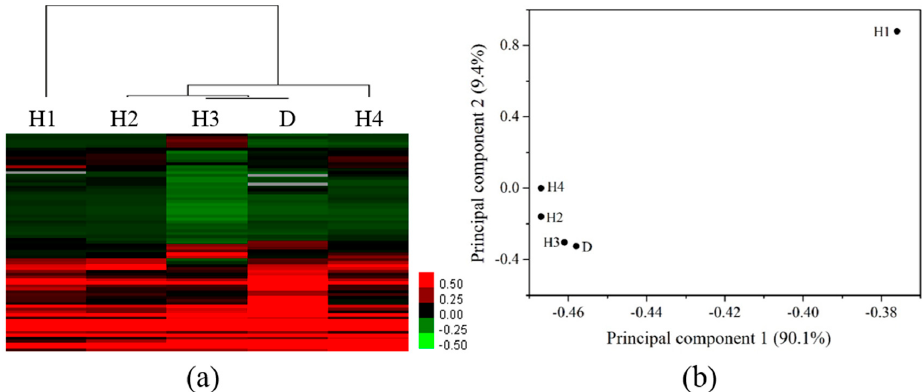
Figure 5. Hierarchical clustering ( a ) and principal component analysis ( b ) of chemicals detected in the surface water from the Hun River. 82 chemicals were used for clustering analysis and PCA. Scale shows fold differences in expression versus controls ( a ).